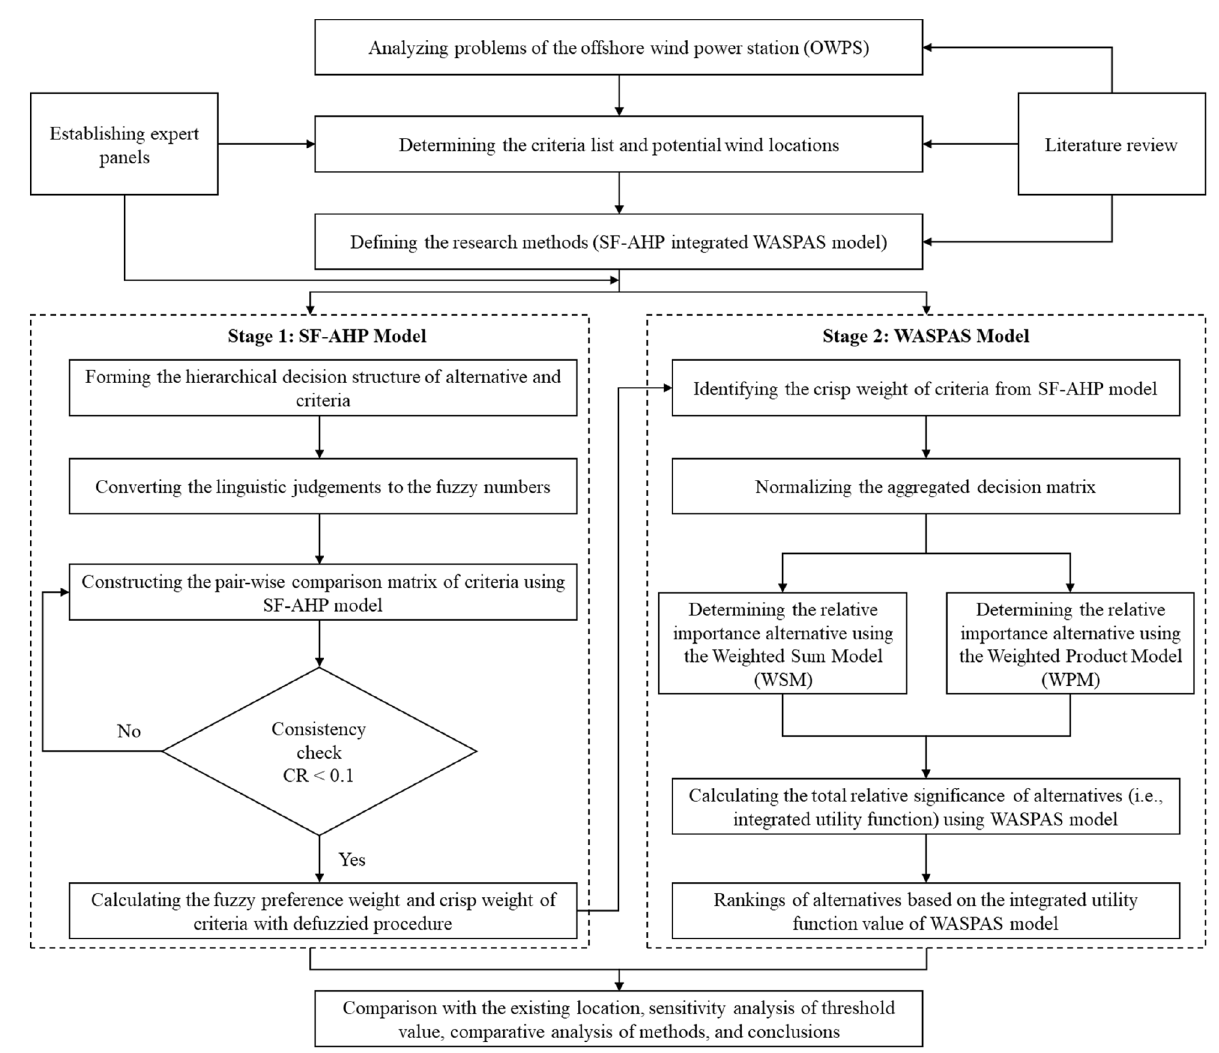
Figure 2. The proposed framework of the